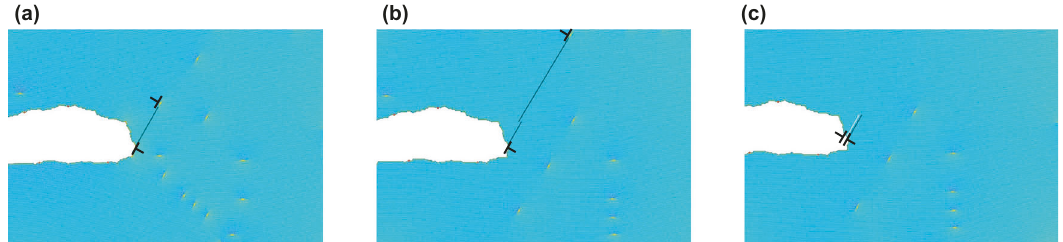
Fig. 4 Example of crack growth by the intersection of slip traces in a 2D hexagonal lattice simulation, [600 b × 300 b ] Δ K * = 3.09. The black dislocation dipole in a highlights a dislocation that has been emitted from the crack on the upload of cycle 82. Upon further loading, b Shows the slip trace of the emitted dislocation (black line) having been intersected by an other dislocation slip trace. Upon unloading, c shows the highlighted emitted dislocation having returned to the crack tip in an offset location, leaving a pair of offset slip trace segments and removing an atom from the crack tip. Atoms are colored by strain relative to perfect lattice to illuminate dislocation In all but the slip plane shifting case, the simulations were performed up to the highest Δ K I achievable with our computational resources. Increasing Δ K I increases the number of discrete dislocations in the continuum domain, the size of the needed atomistic domain to capture the highly nonlinear zone around the crack tip, and the number of time steps required to capture the deformation per loading cycle. The load ratio, R , was selected to balance the computational expensive of simulating large deformations against the sporadic occurrences of crack closure / rewelding that can occur at low R values. Given that our simulations correspond to near threshold fatigue crack growth in vacuum, we do not expect crack closure nor